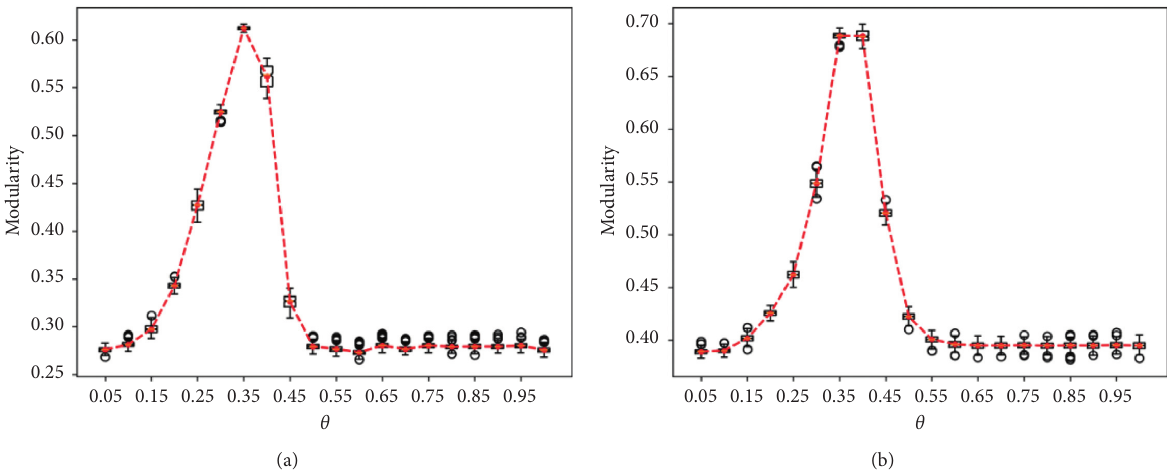
Figure 5: The modularity of the final network structure under different similarity thresholds. The modularity of the (a) ER network and (b) BA